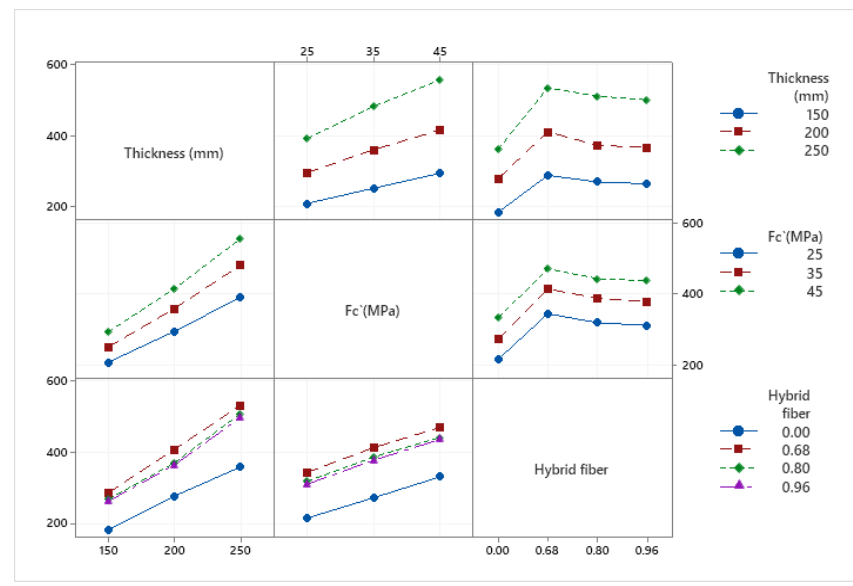
Figure 7. Interaction plot for ultimate load capacity Pu (kN).